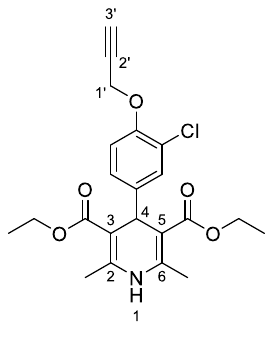
Figure 9. Chemical stucture of 3h .